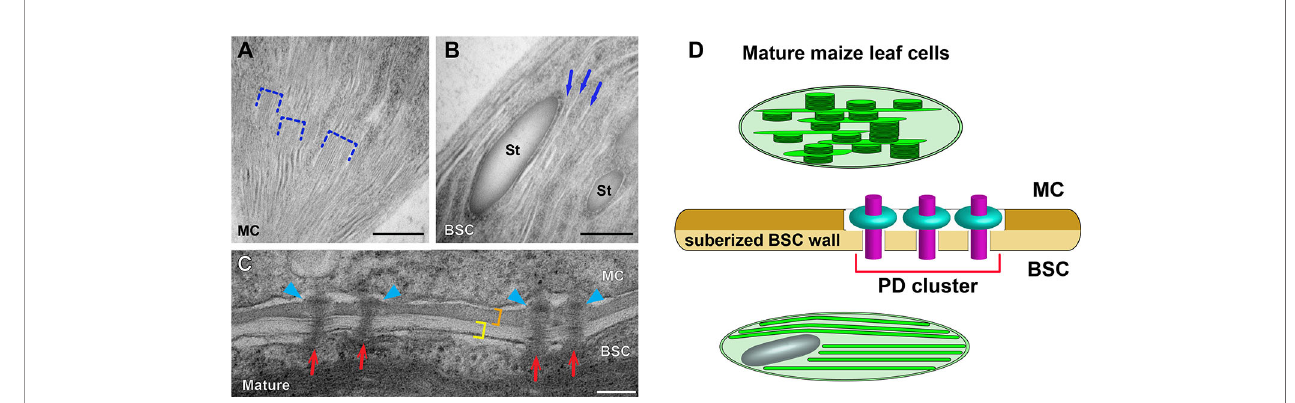
FIGURE 2 | Dimorphic chloroplasts and plasmodesmata in Kranz anatomy of the maize leaf. (A, B) Transmission electron micrographs of a mesophyll cell (MC) chloroplast and a bundle sheath cell (BSC) chloroplast. Grana stacks (dashed brackets) are abundant in the MC chloroplast (A) . Thylakoids are monolayered in the BSC chloroplast (B) . Three unstacked stroma lamellae are marked with arrows in B. (C) Plasmodesmata (PD) at the MC-BSC interface of mature (D) maize leaf tissues. PD (red arrows) in the mature tissue have “ sphincter ” rings in the MC side wall (blue arrowheads). The BSC wall (yellow bracket) is suberized and it is stained differentially from the MC wall (orange bracket). (D) A diagram illustrating the dimorphic chloroplasts and PD in the maize leaf based on data published in 1996; Evert et al. (1977); Danila et al. (2016), and Mertz and Brutnell (2014). MCs and BSCs are linked via clusters of specialized PD that transverse a suberized cell wall. St: starch particle. Scale bars in (A, B) and (C, D) indicate 500 nm, and 100 nm,